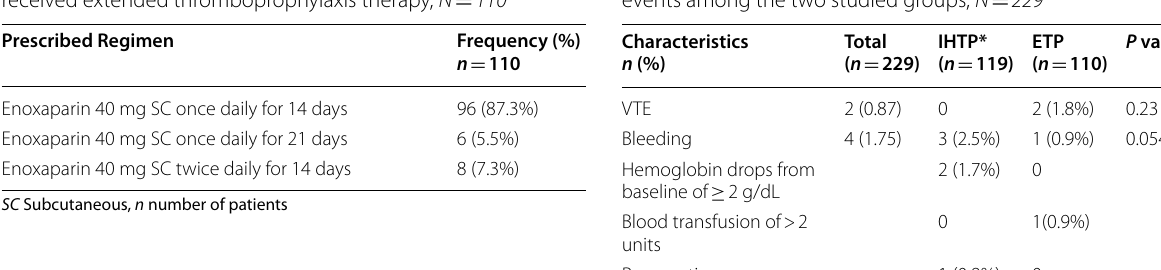
BMI Body mass index, n number of patients, chi-square, or Mann–Whitney test were used to compare between data at level of significance < 0.05